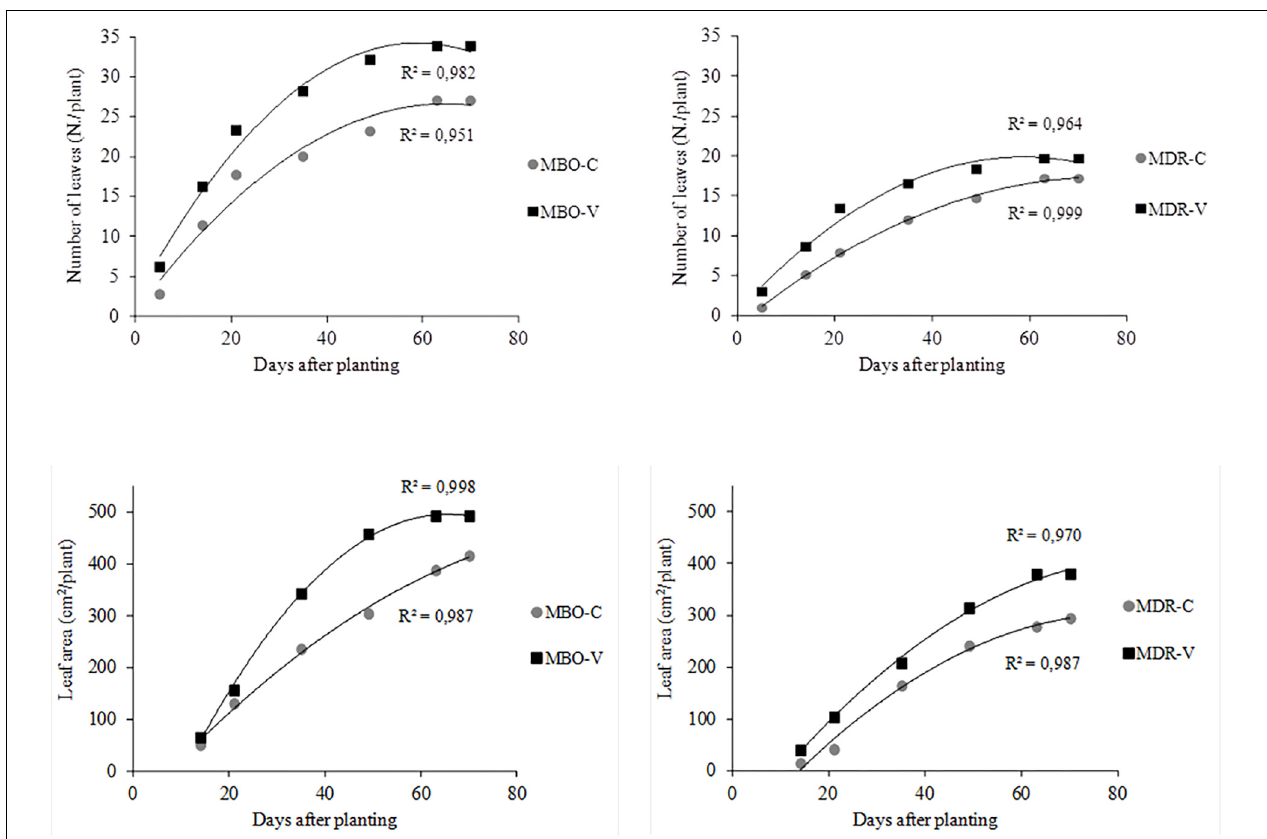
FIGURE 3 | Time evolution of the number of leaves and plant leaf area in plants of Ranunculus asiaticus L. hybrids MBO and MDR, obtained by two preparation procedures of tuberous roots, only rehydration (Control, C) and rehydration followed by vernalization (V). Mean values; n =